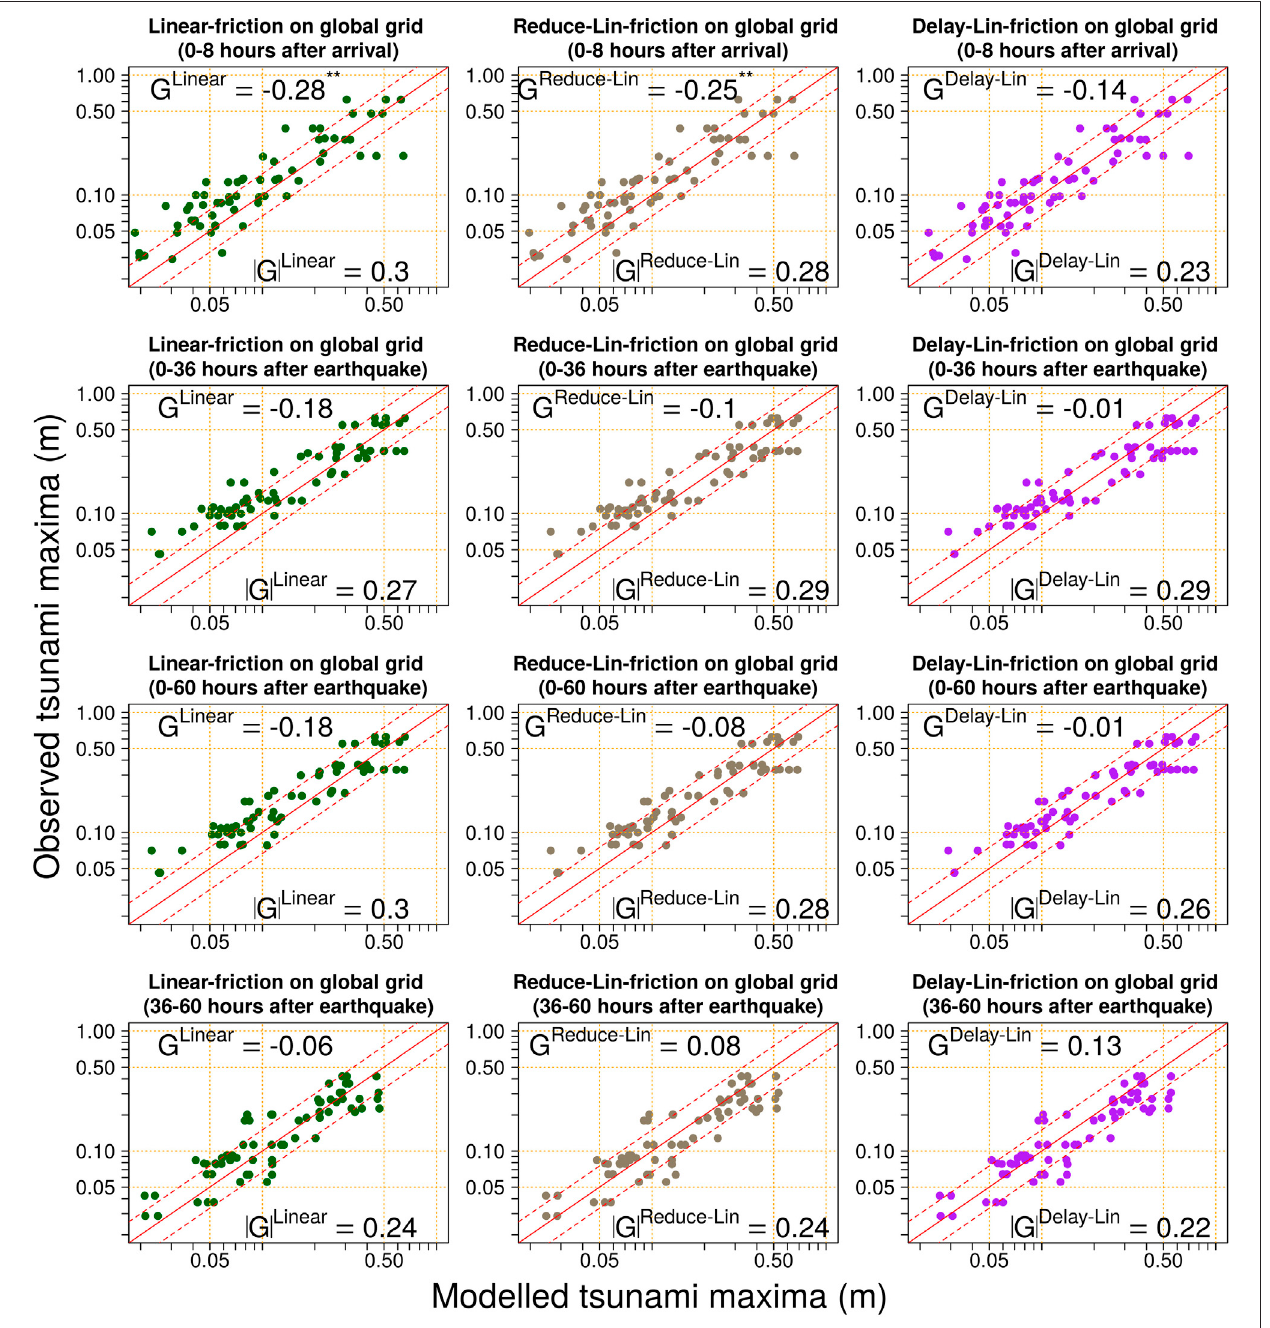
FIGURE 11 | Modelled-vs-observed tsunami maxima for different global model types (linear-friction, linear-friction with a lower friction factor, linear-friction with delayed onset of 12 h), and different temporal subsets of the simulation (0 – 8 h after tsunami arrival; 0 – 36 h after earthquake; 0 – 60 h after earthquake, 36 – 60 h after earthquake). Diagonal solid line is y (cid:2) x ; diagonal dashed lines are y (cid:2) 1 . 5 x and y (cid:2) x / 1 . 5. The LHS column is the same as in Figure 10 .